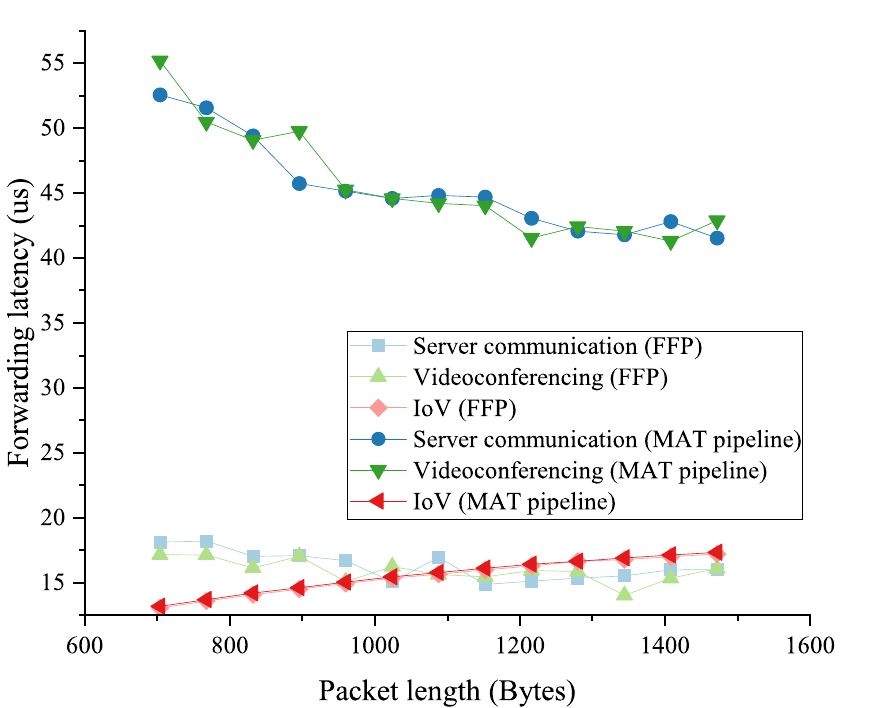
Figure 12. The low-latency traffic forwarding latency of the FFP and the MAT pipeline in the native POF